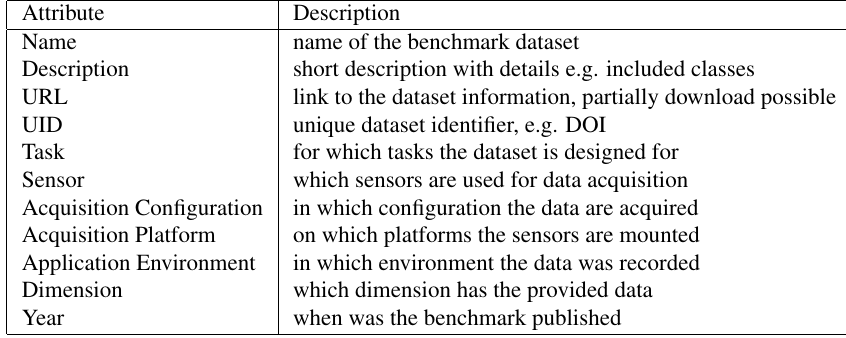
Table 1. Defined relevant metadata attributes for benchmark datasets.